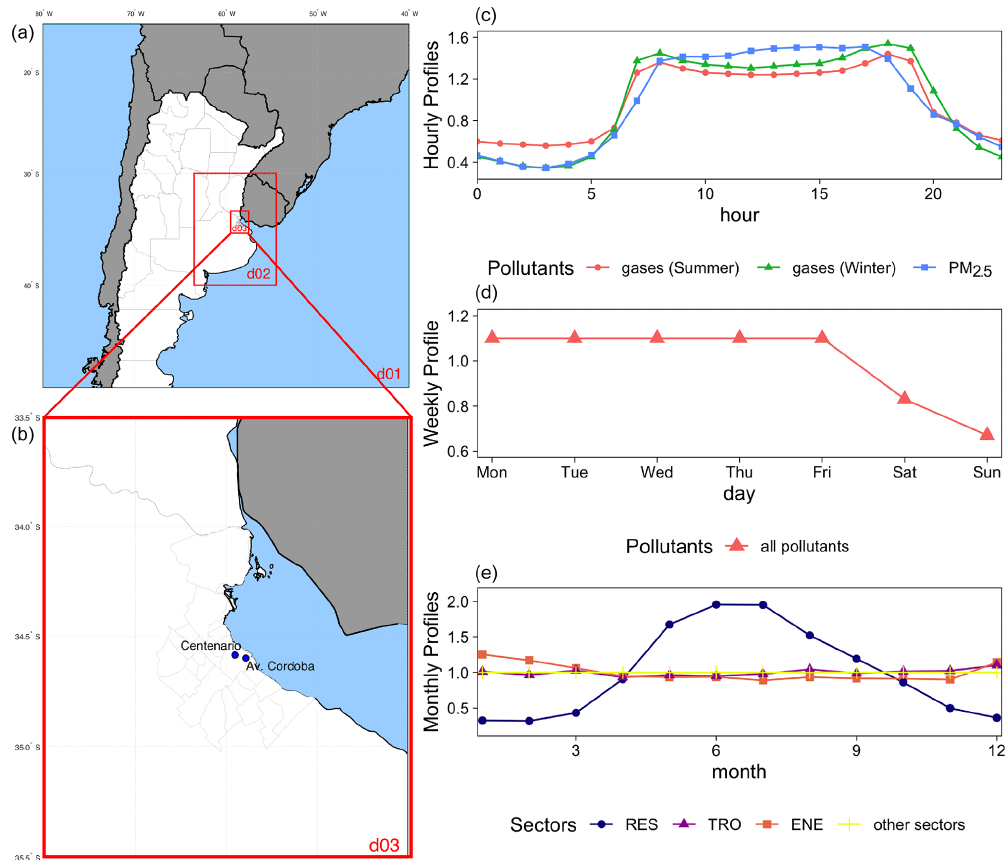
Figure A2. (a, b) Location of WRF-Chem domains. Blue dots are the monitoring site locations. (c, d, e) Hourly, weekly, and monthly variations used for the temporal disaggregation of emissions within this